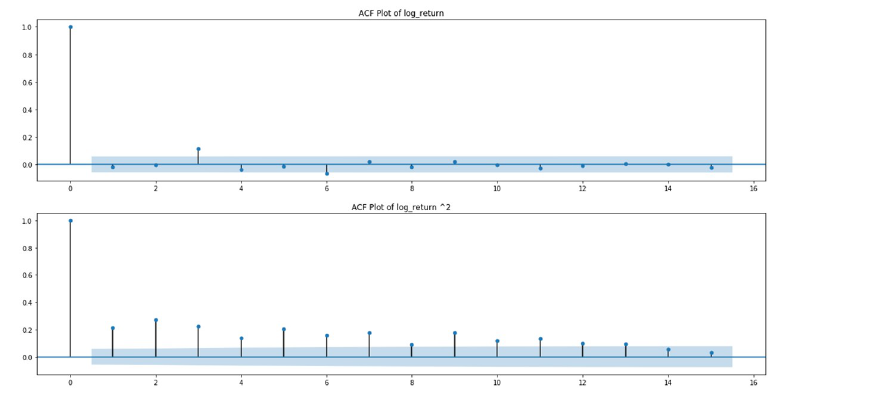
Fig 10. ACF plot of log return and squared log return of the